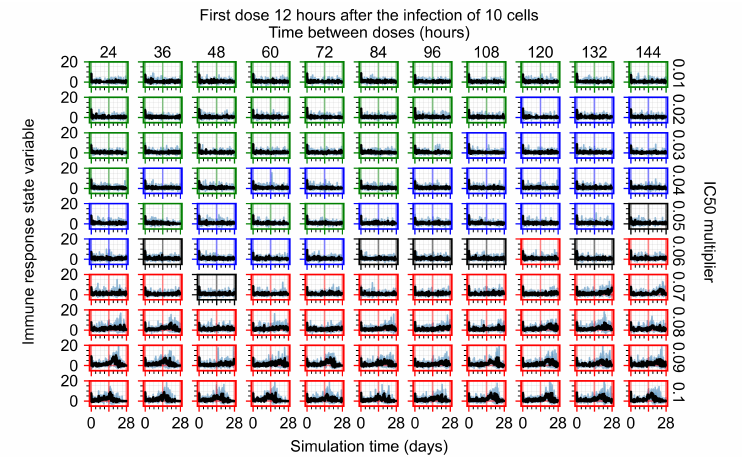
Figure A90. Immune response state variable number. Positive values correspond to an inflammatory state, and negative to an anti-inflammatory state.